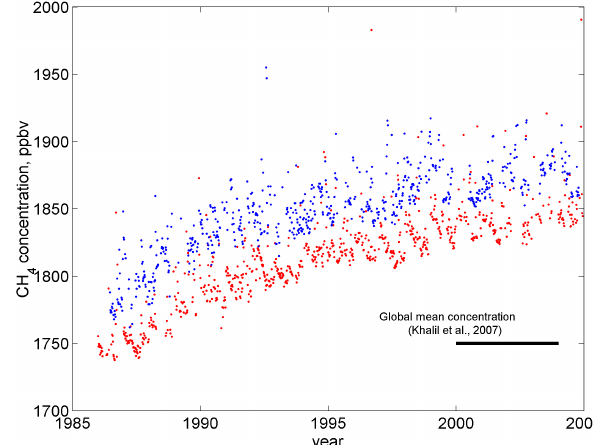
Figure 2. Daily averaged methane concentration obtained from NOAA / CMDL data at Barrow: red dots – summertime (June–July) data; blue dots – wintertime (December–January)